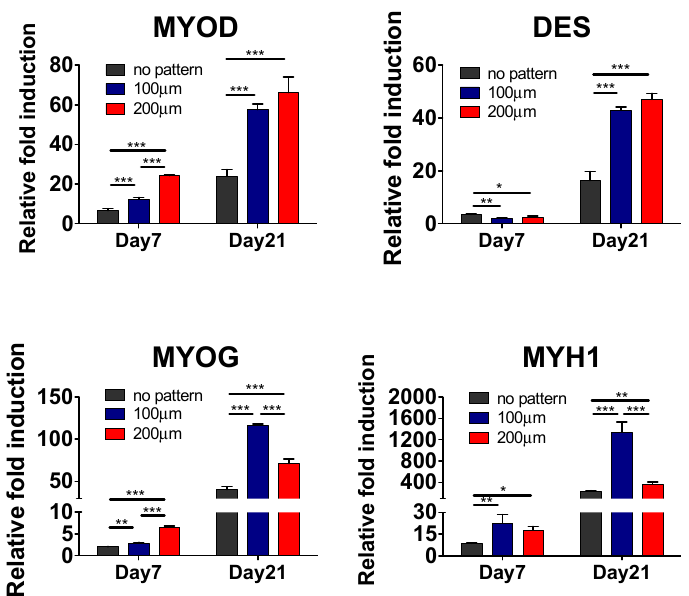
Figure 4. In vitro myogenic differentiation of hESC-derived PDGFRA + myogenic progenitor cells cultured on PDMS substrates with various topographical features. Gene expression profiles of PDGFRA + cells cultured on PDMS cell culture substrates with various topographical features. Statistical analysis was performed among cells cultured in different cell culture substrates within the same time point. * p < 0.05, ** p < 0.01 and *** p <